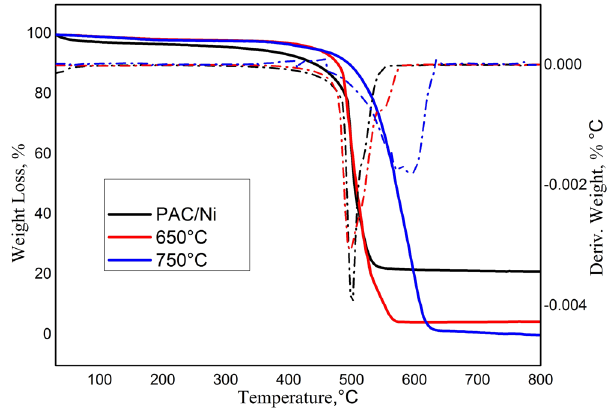
Figure 8. TGA and DTG spectra of PAC/Ni and CNM produced at 650 and 750